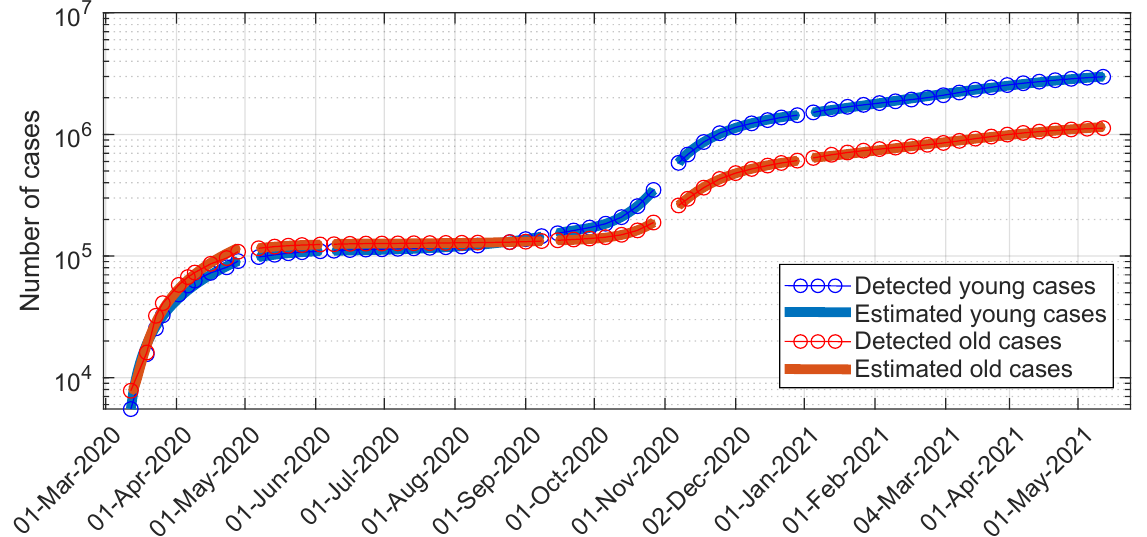
Figure 1. Data fitting for the compartmental model: actual and estimated cumulative profiles for young subjects infected and old subjects infected (logarithmic